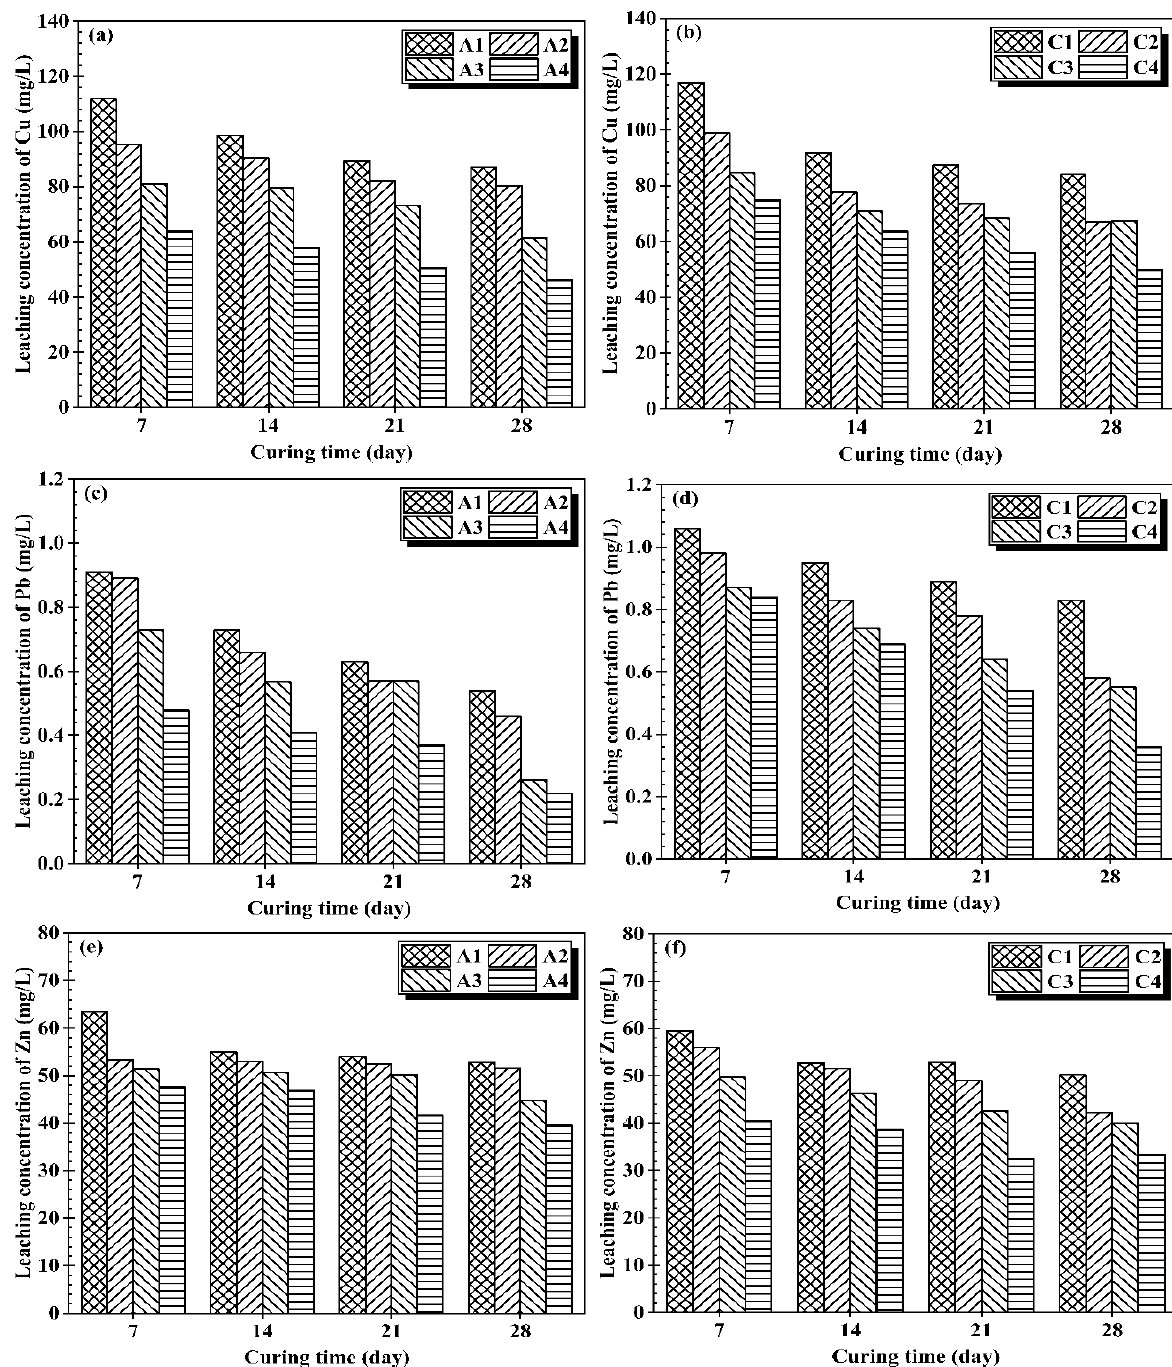
Figure 4. Leaching concentration vs. binder percentage: ( a ) Cu in OPC samples, ( b ) Cu in CG samples, ( c ) Pb in OPC samples, ( d ) Pb in CG samples, ( e ) Zn in OPC samples, ( f ) Zn in CG samples.